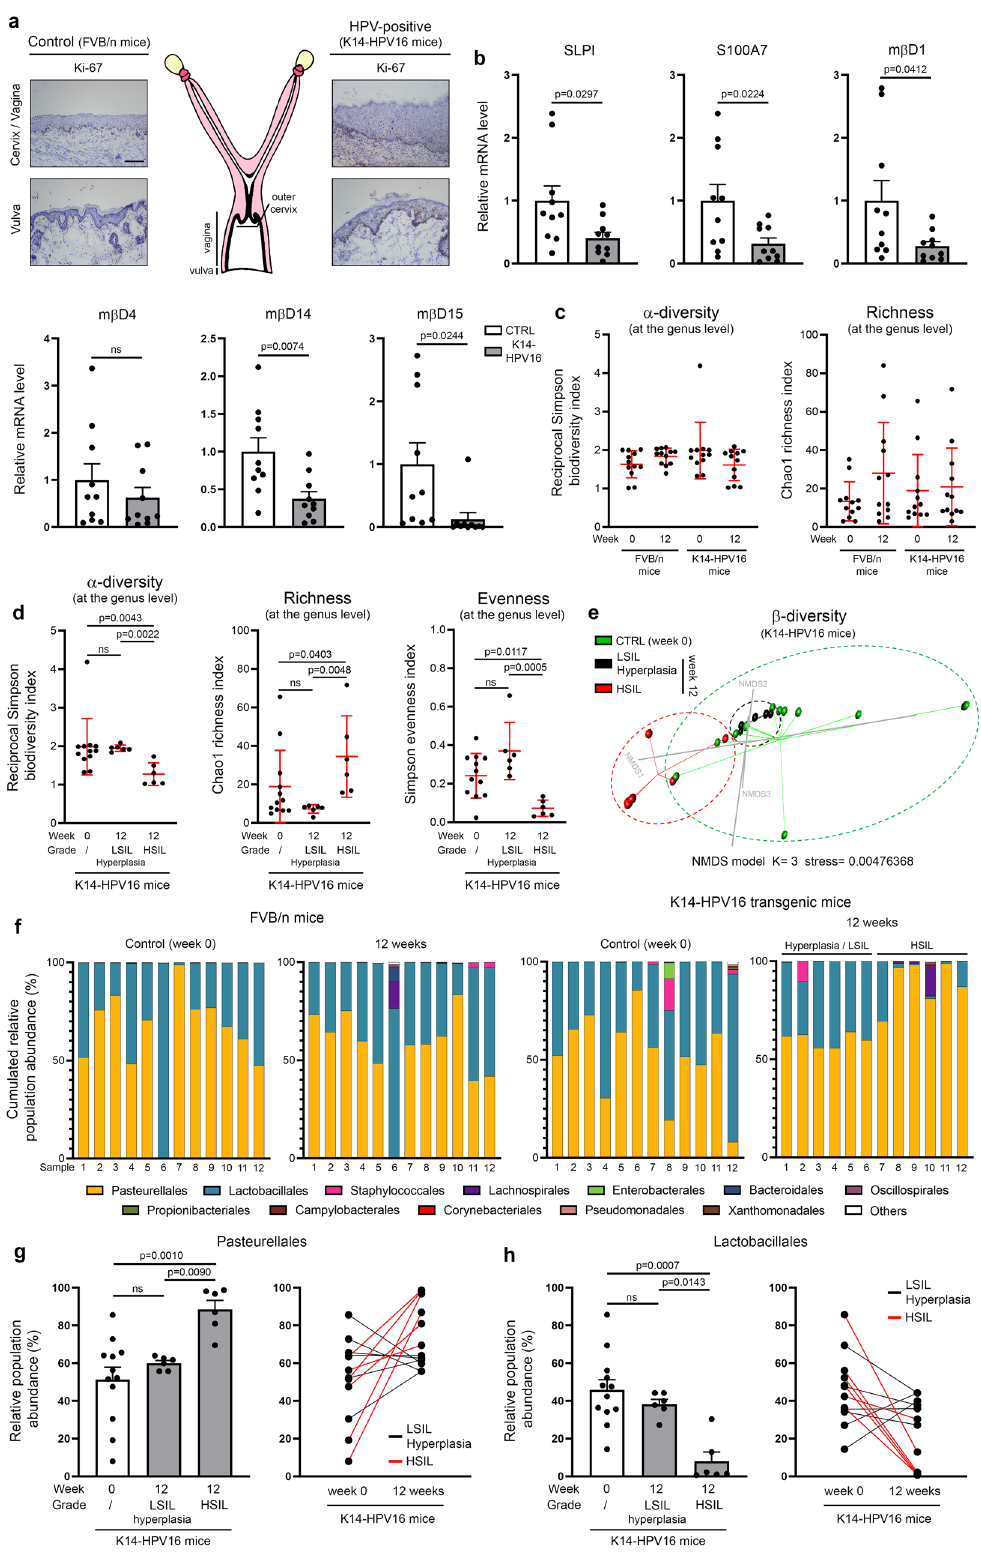
assay (Abbott, Wiesbaden, Germany) which enables simultaneous detection of all WHO/IARC-classi fi ed carcinogenic (high-risk) HPV types (HPV16, 18, 31, 33, 35, 39, 45, 51, 52, 56, 58, 59, 66, and 68). The vaginal bacterial fl ora was systematically assessed for all patients during the entire study period and BV was diagnosed using the Hay/Ison grading system, a simpler version of Nugent ’ s score displaying the same high performance for BV diagnosis 71,72 . First described in 2002 71 , this method evaluates a shift from a vaginal fl ora rich in Lactobacilli to a